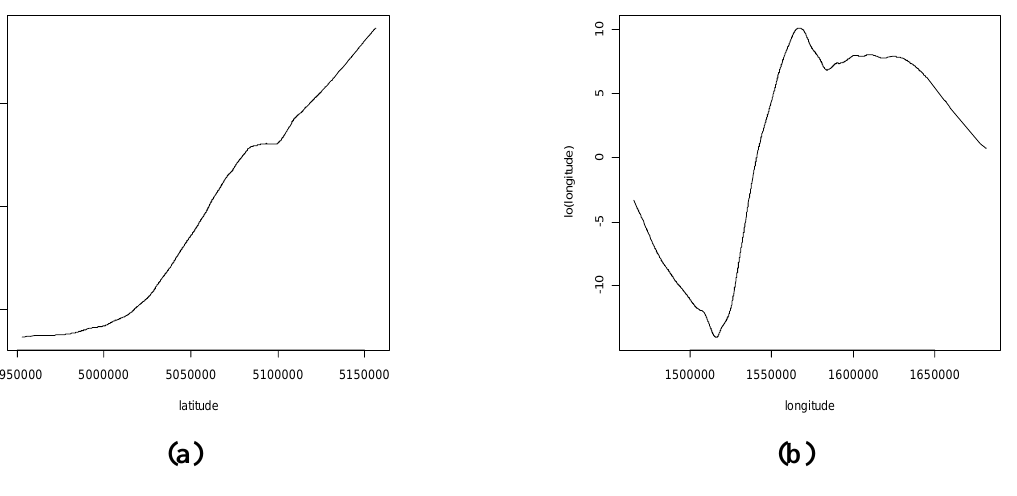
Figure 3. (a) South-North trend of IRC. (b) East-West trend of